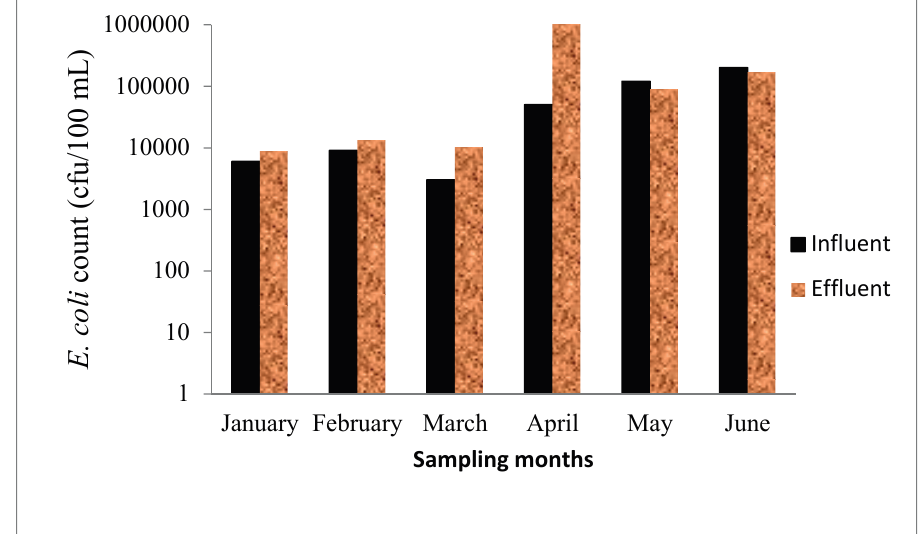
Figure 4. E. coli count in the influent and effluent of Thohoyandou